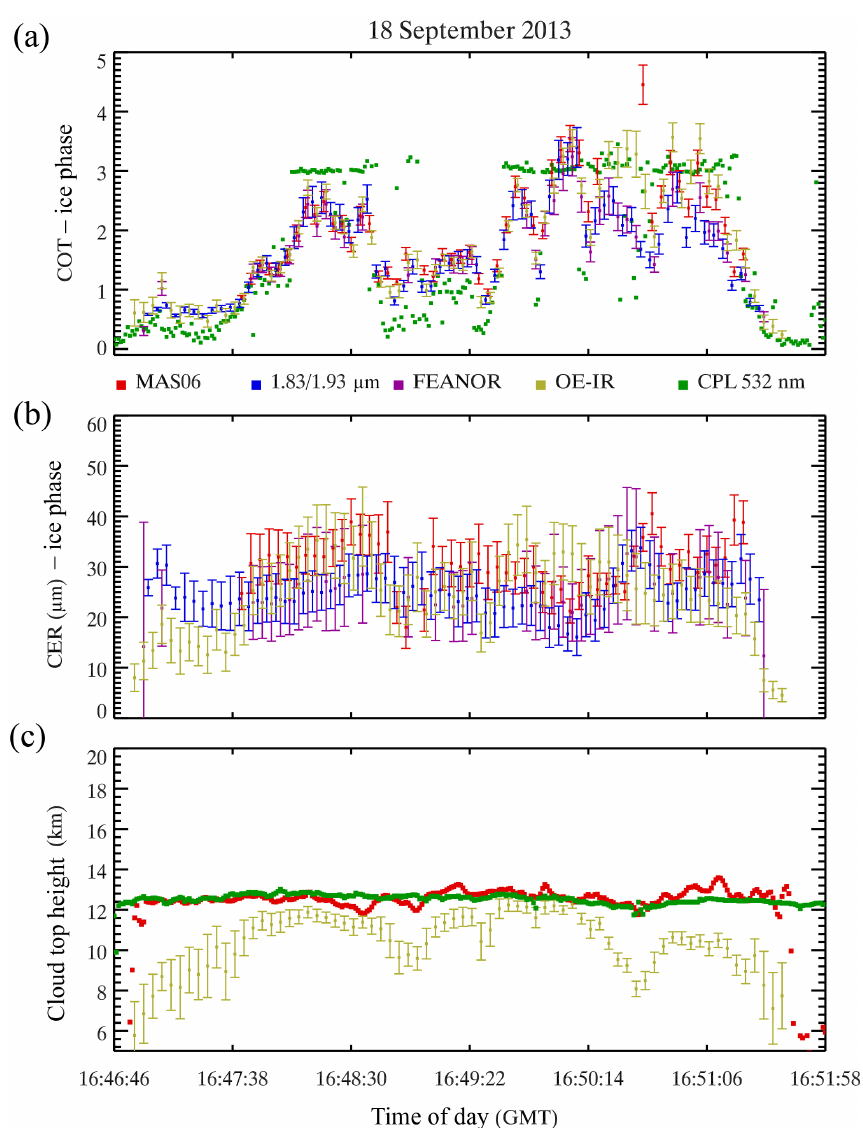
Figure 7. Same as Fig. 5 but for the track shown in Fig.